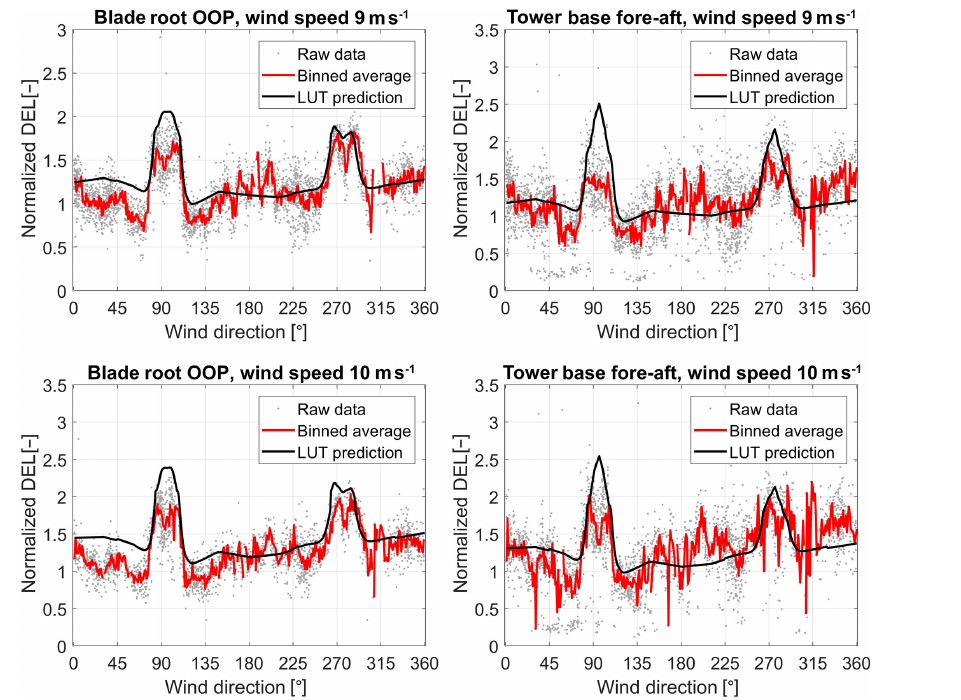
Figure 9. Comparison of LUT load prediction to EWTW measurements at 9 and 10ms − 1